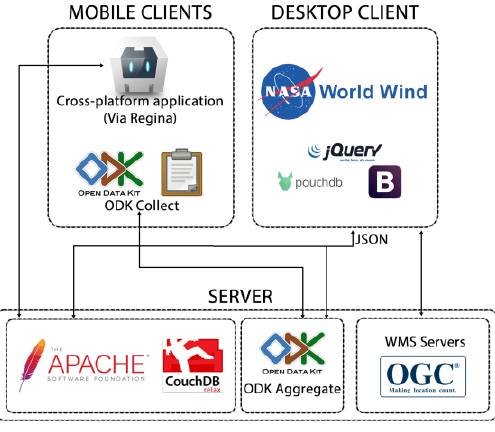
Figure 6. System architecture of the